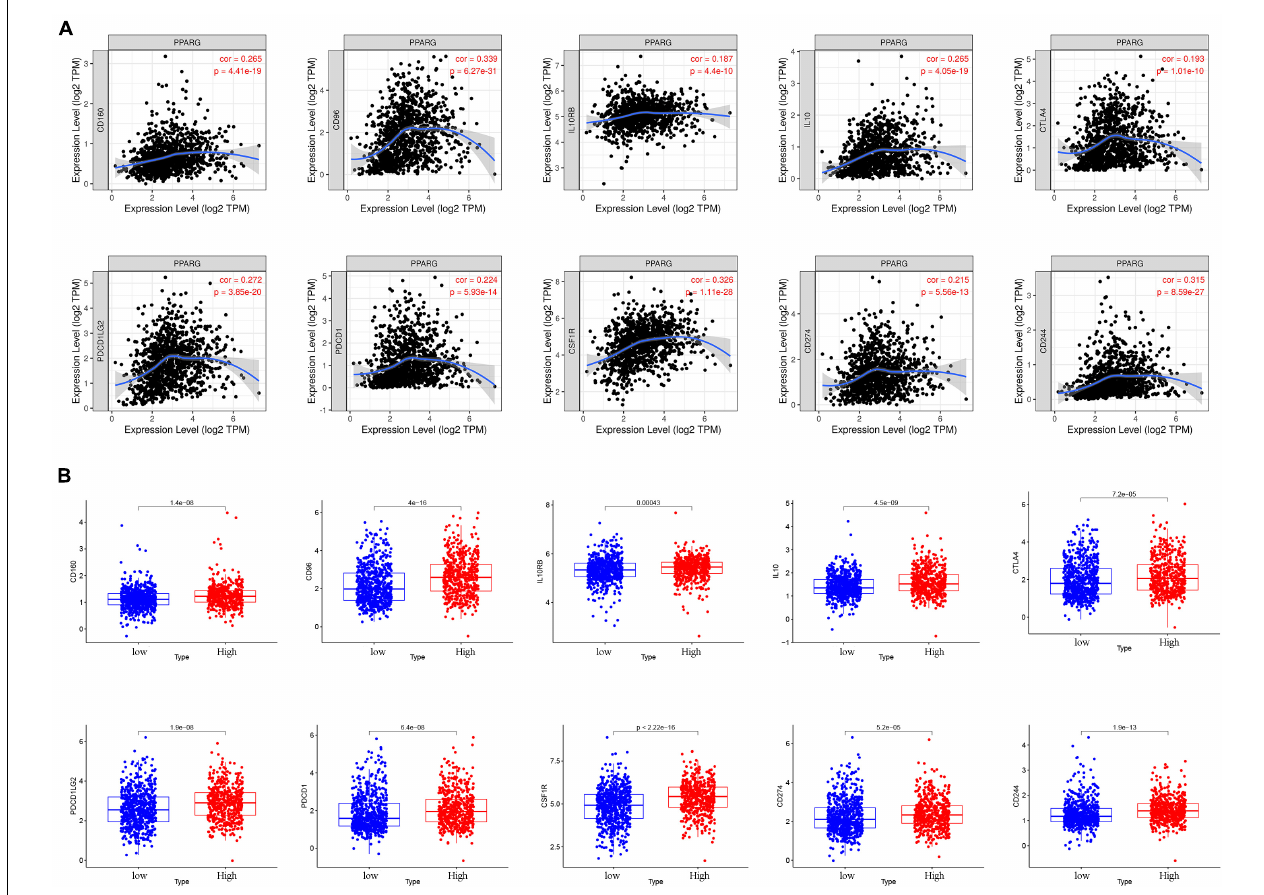
FIGURE 8 | The relationship between PPARG and immune checkpoints. (A) Analyze the correlation between PPARG and immune checkpoints through the TIMER database. (B) Analysis of the difference of immune checkpoints between high- and low- PPARG expression